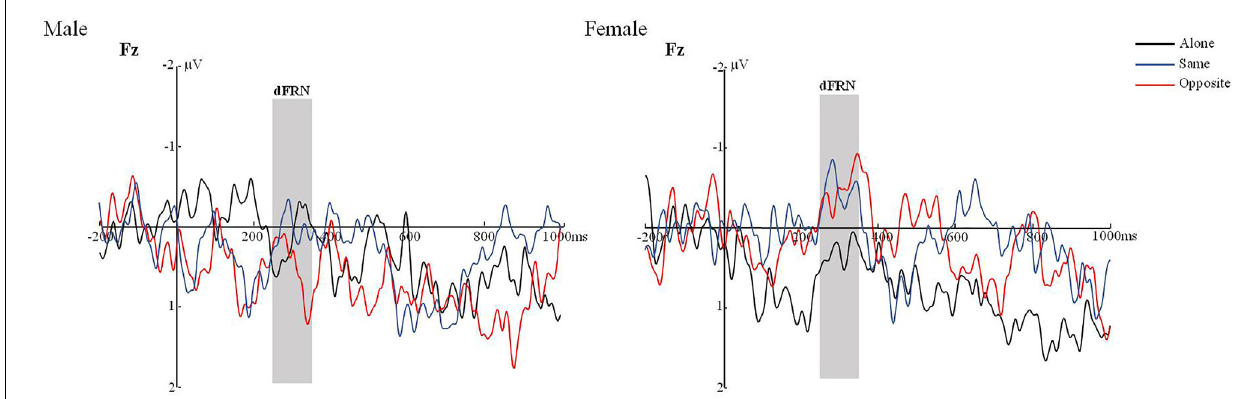
FIGURE 3 | The dFRN of male/female in different joint task